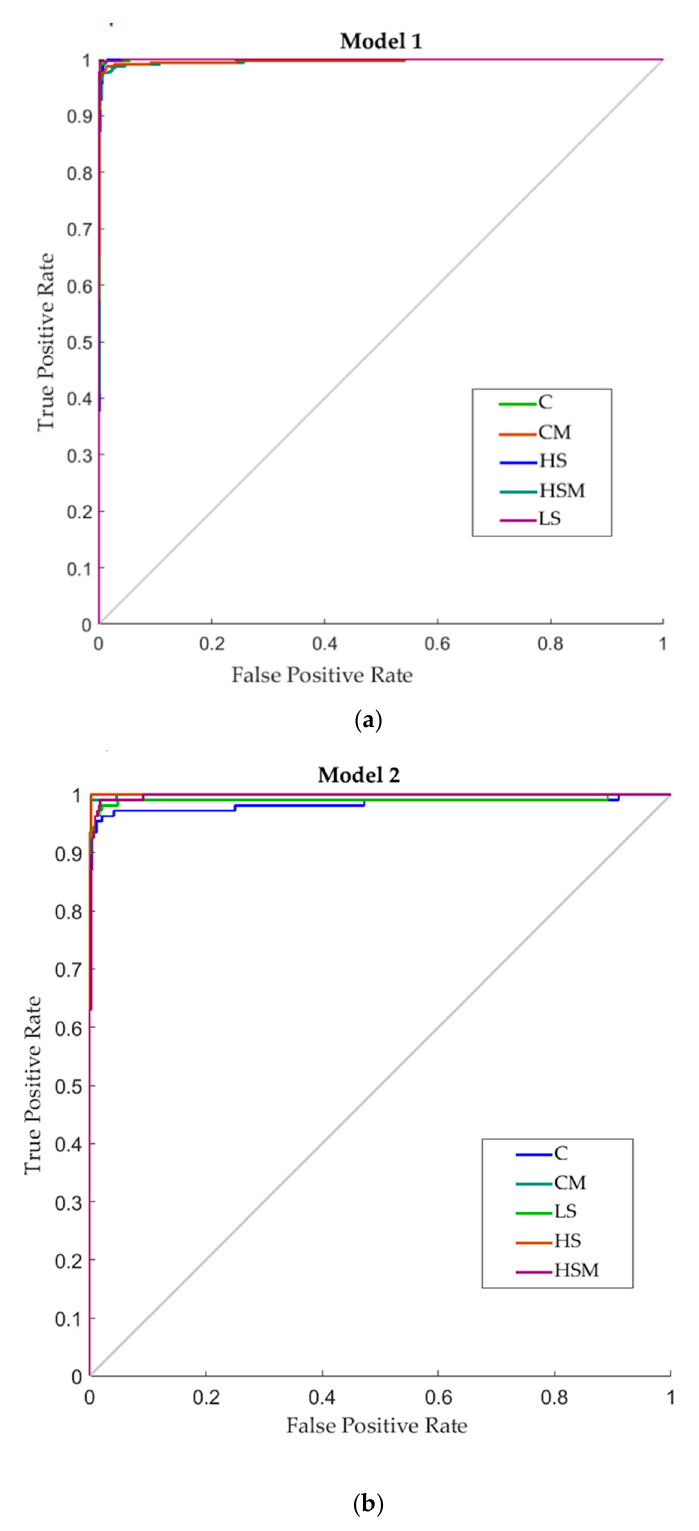
Figure 7. Receiver operating characteristic (ROC) curves for the two models developed ( a ) the microPHAZIR TM leaf model, ( b ) the microPHAZIR TM berry model. Colored lines represent the different smoking treatments. Abbreviations: C = control without misting; CM = control with misting; HS = high density smoke without misting; HSM = high density smoke with misting; and LS = low density smoke.